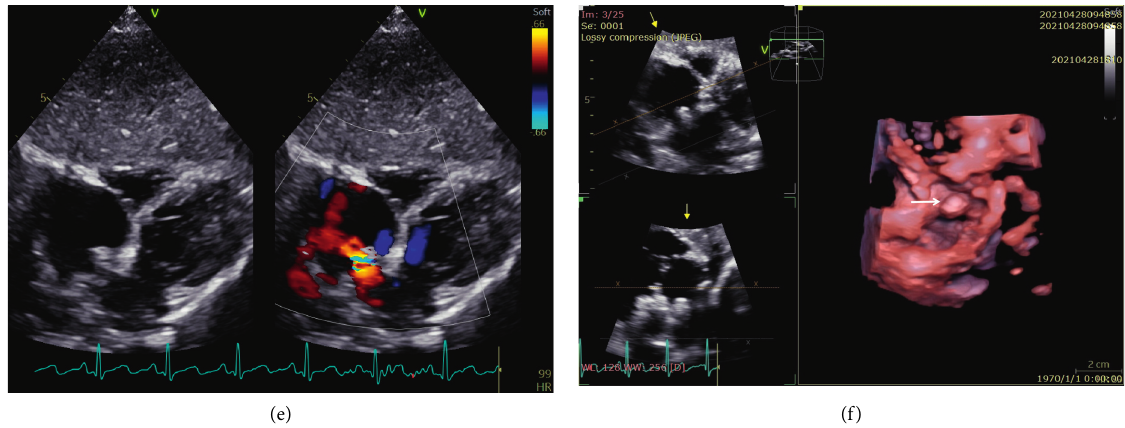
Figure 5: Device deformation in Patient no. 2. (a-b) TTE at the 12-month visit demonstrated that the right disc expanded to the right atrium. (c-d) TTE at the 24-month visit demonstrated that, as the device was partly degraded, a new onset residual shunt appeared. (e-f) TTE at the 36-month visit demonstrated the shrinkage size of the device and increased size of the residual shunt (e). 3D-TTE showed that the right disc apposition and incorporation into adjacent myocardium were not completed (f). White arrow indicated the remaining part of the right